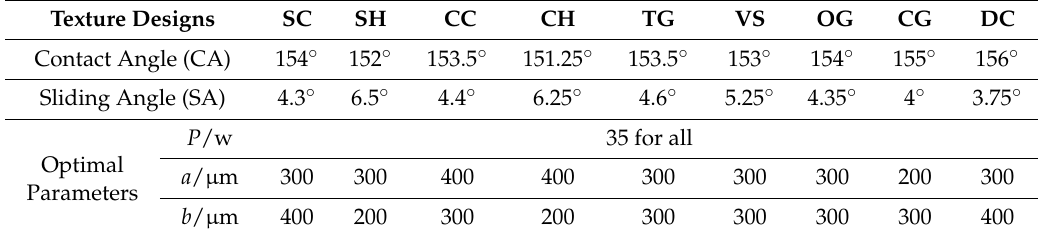
Table 1. The optimal parameters of the surface texture designs with the best hydrophobicity.